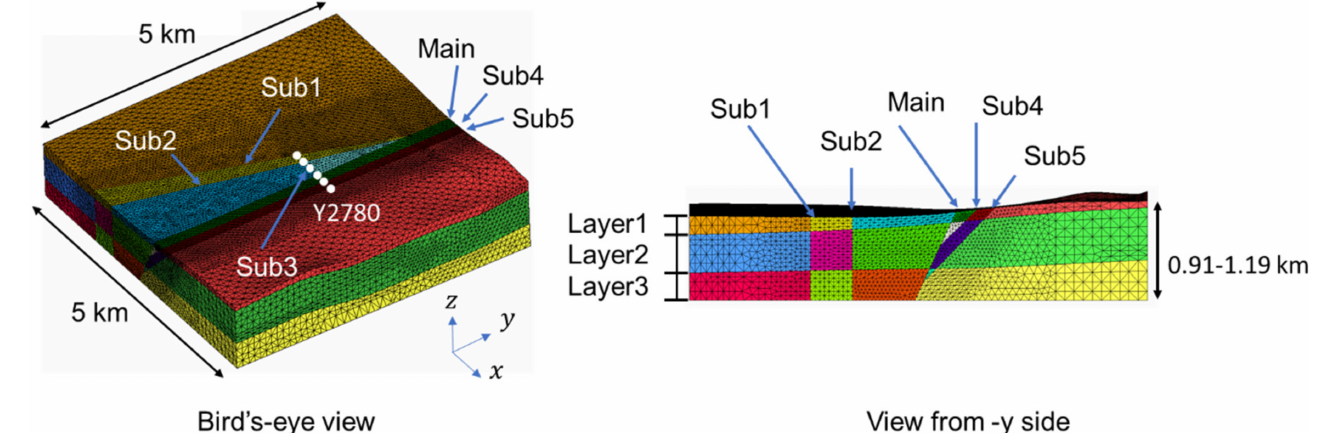
Figure 8. Finite element mesh. The analytical model is divided into three layers with different material properties. The layers are further divided by six faults. The analytical model is displayed with color-coded blocks divided by faults and property boundaries. Its depth depends on the elevation of the ground surface and ranges from 0.91 to 1.19 km. The black area on the ground surface in the figure viewed from the -y side represents the undulation of the ground surface.